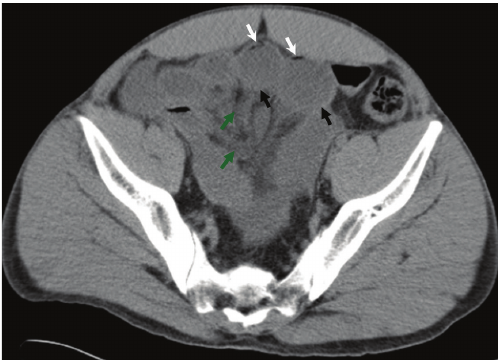
Figure 1: Computed tomography of the abdomen reveals multiple loops of mid and distal small bowel were dilated (black arrows) with pneumatosis intestinalis. The white arrows mark areas of air in the small bowel wall. The surrounding mesentery is edematous as marked with the green arrows.